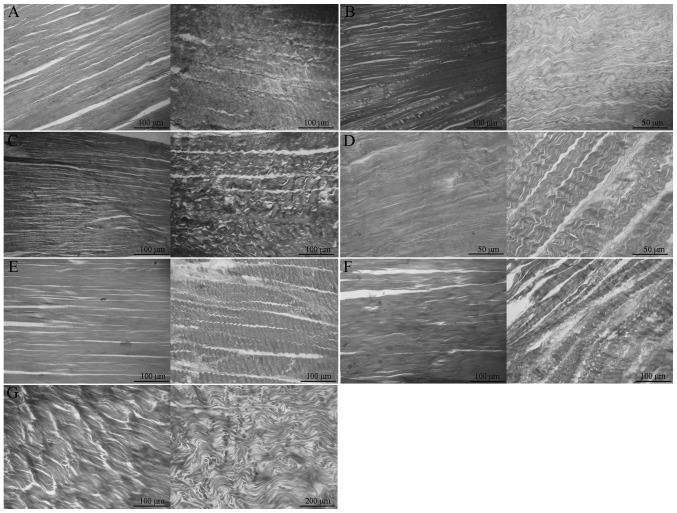
Rabbit limb flexor DT muscle (left, DT; right, ST) arrangement following treatment with (A) PBS (control), (B) 1% Triton-X 100, (C) 1% SDS, (D) 1% TnBP, (E) 1% TnBP + 0.5% SDS, (F) 1% TnBP + 1% Triton-X 100 and (G) 1% Triton-X 100 + 0.5% SDS decellularization methods. ST, semitendinosus ; DT, digitorum; Triton-X 100, t-octyl-phenoxypolyethoxyethanol; SDS, sodium dodecyl sulfate; TnBP, tri-n-butyl phosphate; PBS, phosphate-buffered saline.